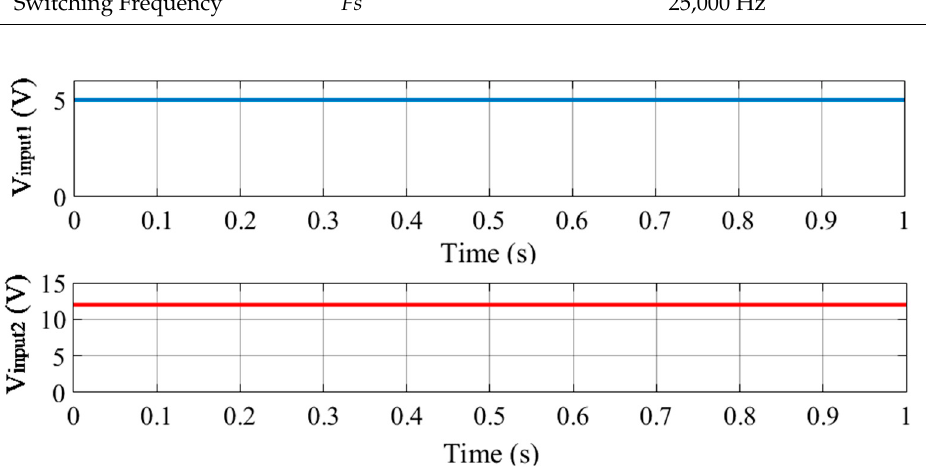
Figure 7. Simulation response of input voltage waveform.